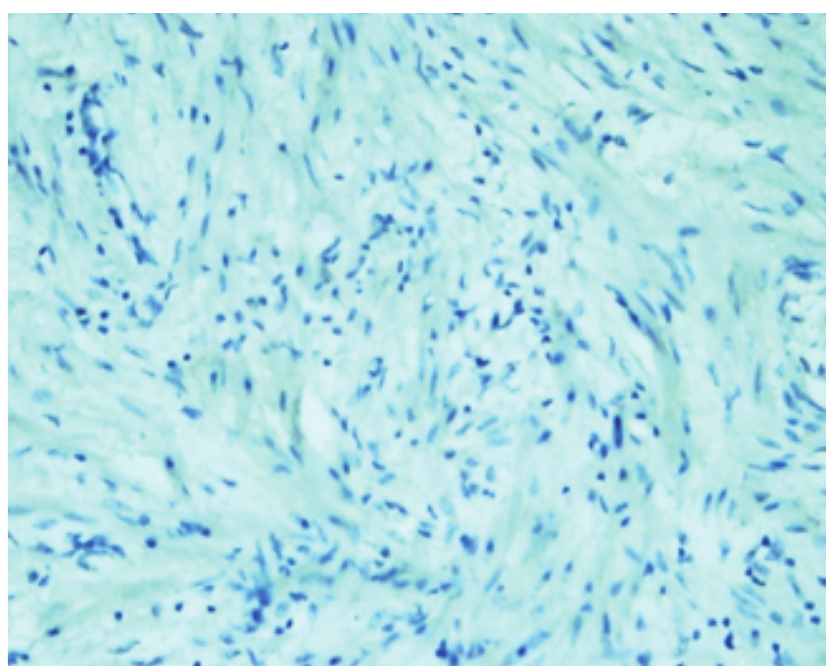
Figure 4: Cyclin D1 staining in benign prostate tissue, showing negative staining of the benign prostatic tissue and the absence of staning in the nucleus grade